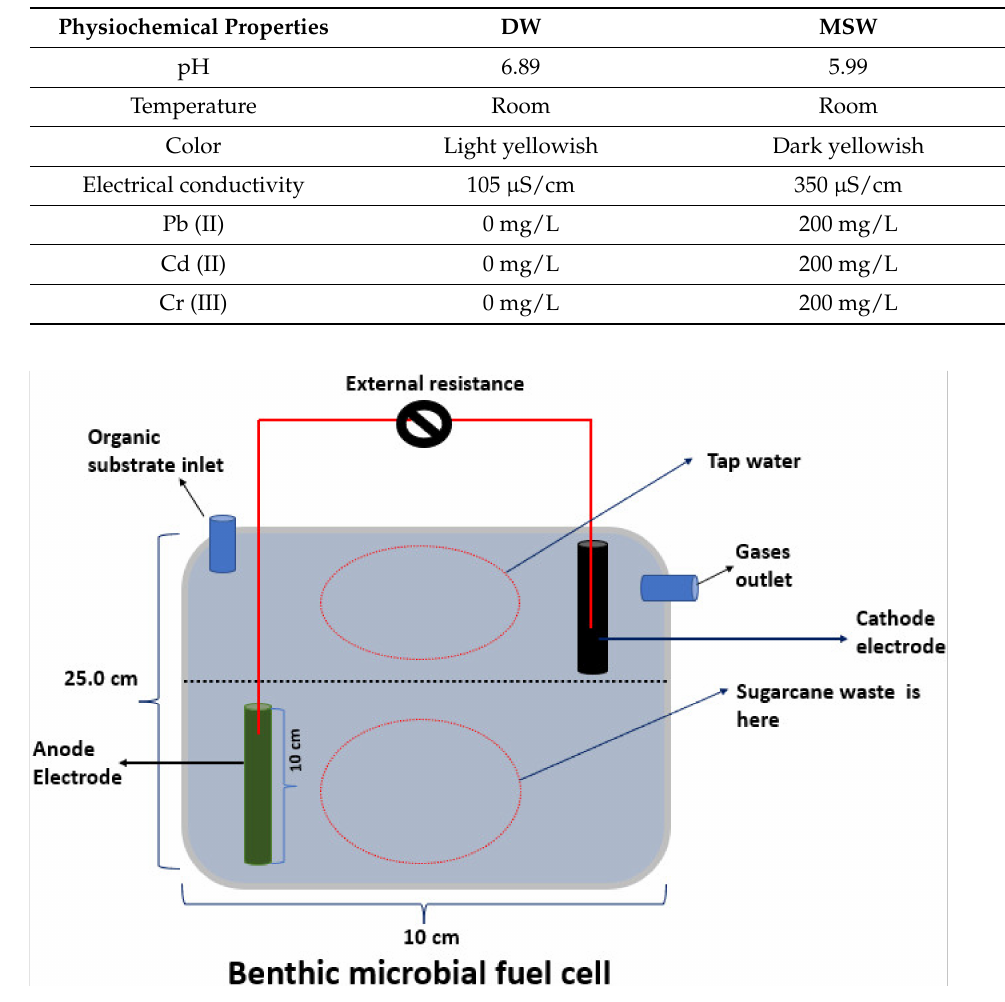
Figure 1. The conceptual setup of the BMFC in this